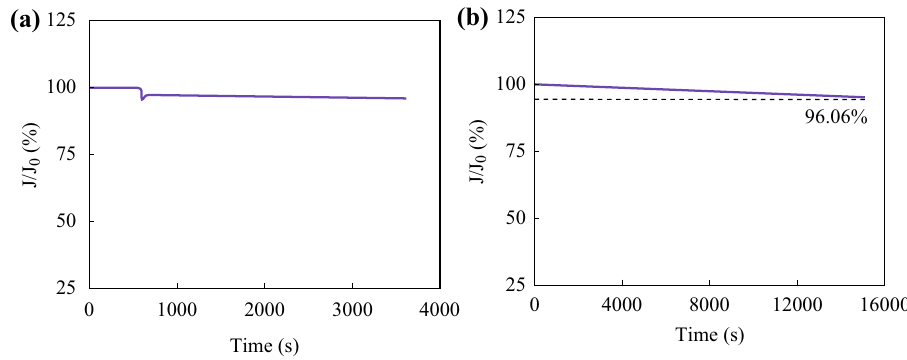
Fig. 5 a Chronoamperometric responses of Ni/Co-MOF nanoflakes in O 2 -saturated 0.1 M KOH solution (1600 rpm) without and with 3 M methanol (added at 600 s). b Stability evaluation at - 0.1 V and a rotation speed of 1600